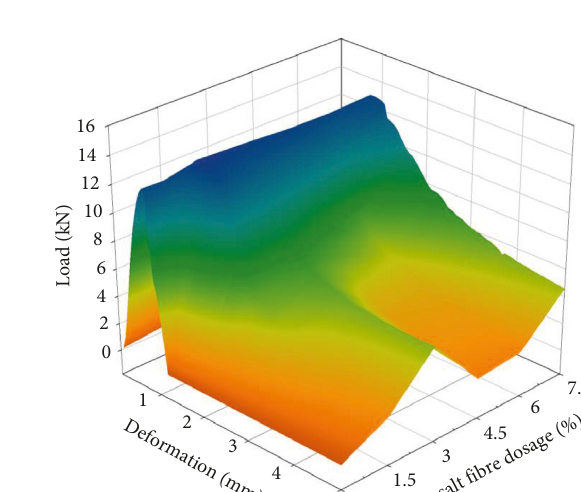
Figure 2: (a) SEM and (b) NMR test.